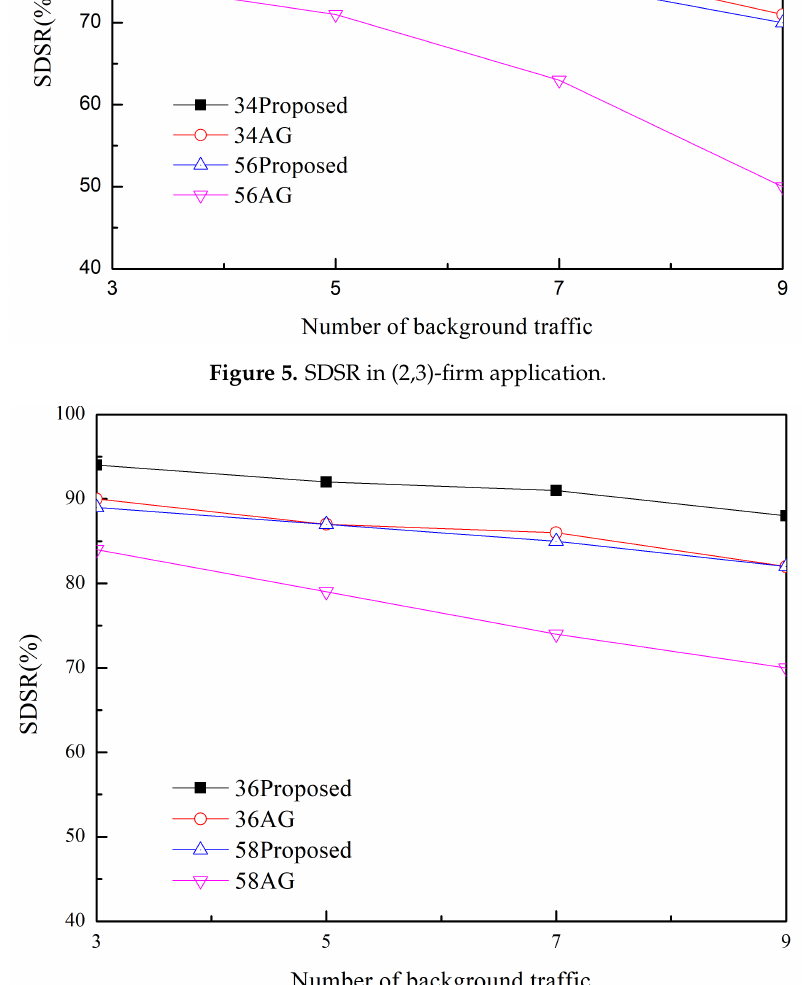
Figure 6. SDSR in (2,5)-firm